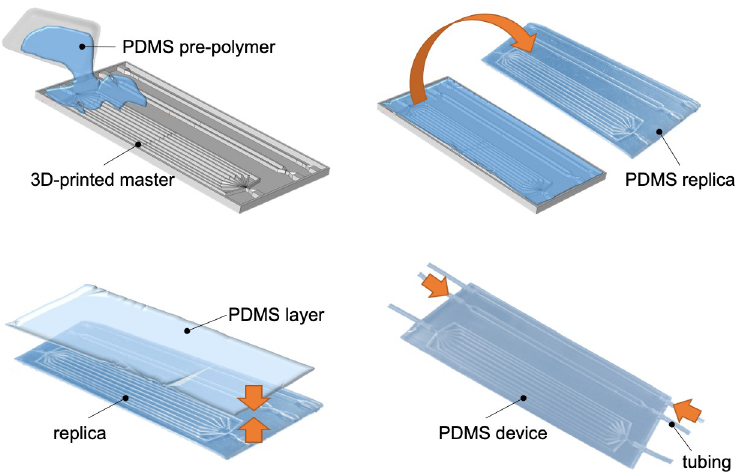
Fig 2. PDMS device fabrication process. Schematic representation of the fabrication process of the